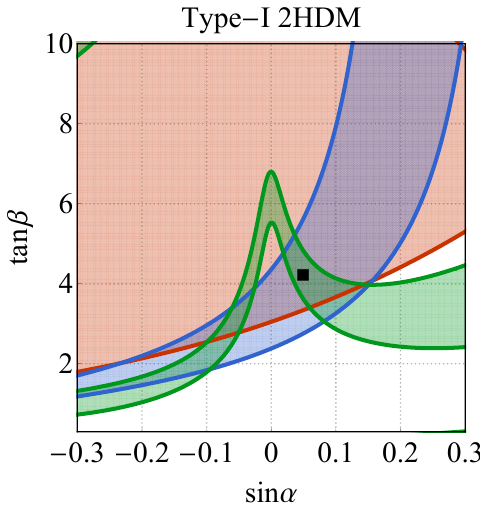
Figure 13 . Allowed/favoured parameter regions in the case of the square ( (cid:4) ) type-I 2HDM benchmark scenario (3.4). The colour coding resembles that of (cid:12)gure